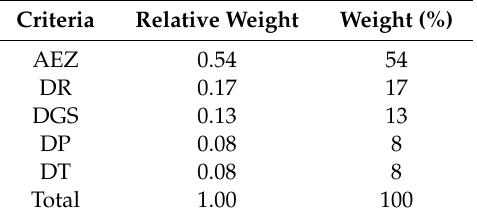
Table 18. Weights of the five criteria of the socioeconomic analysis using the AHP.